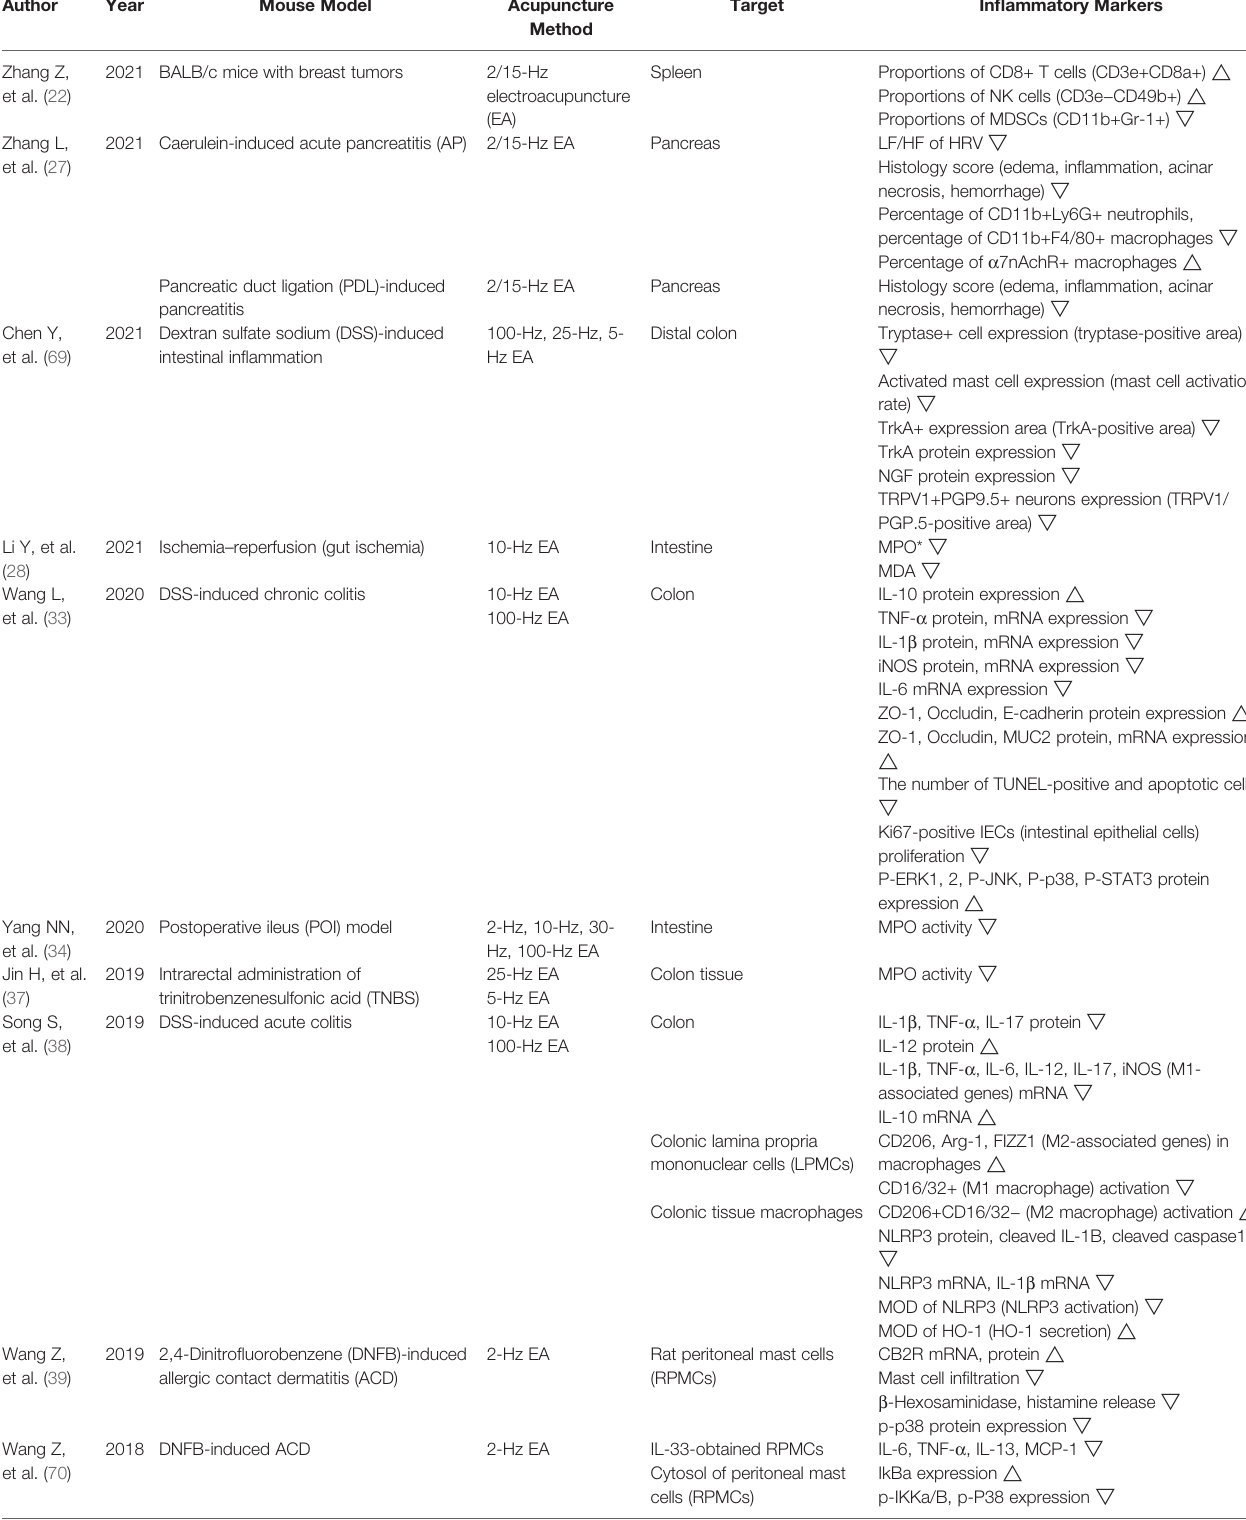
TABLE 2 | Anti-in fl ammatory effect of acupuncture on ST36 in digestive